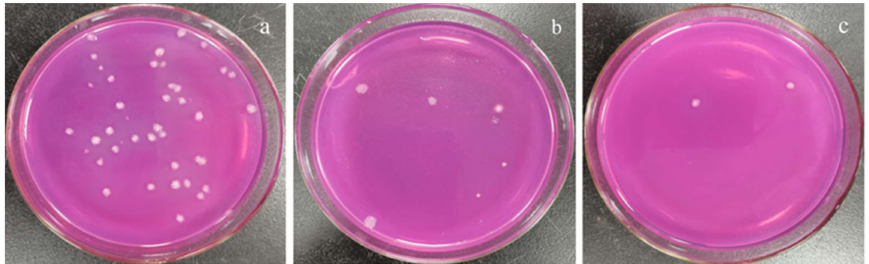
Figure 4. Effect of polypeptides treatment on spore germination rate of A. carbonarius H9 spores. ( a ) 1.6 mg/L polypeptides; ( b ) 3.2 mg/L polypeptides; ( c ) 25.6 mg/L